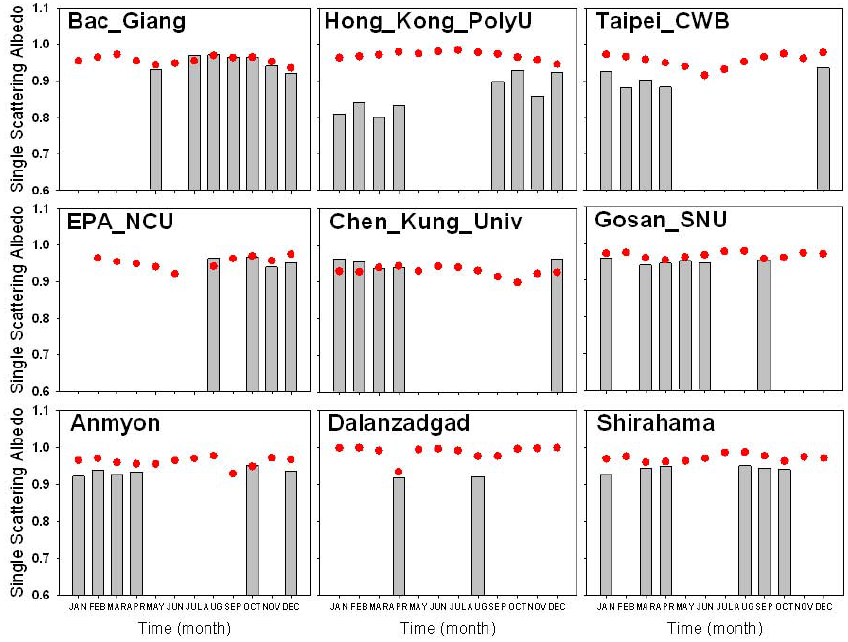
Fig. 6. Monthly variations of CMAQ-simulated and AERONET SSAs at 9 AERONET sites in East Asia for the year, 2006. Grey bars and red circles represent SSAs obtained from AERONET and CMAQ model simulations,